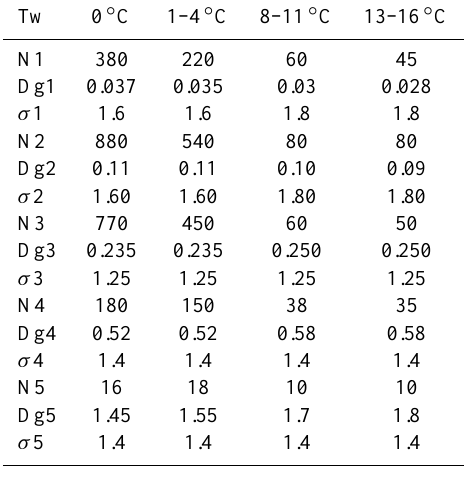
number density for the different salinity bins were compared (Fig. 6). Relative particle number concentrations for particles between 0.10 µm <D p < 0.23 µm are higher for the lower salinities and decrease with increasing salinity until they re- main stable at a salinity of about 15 g kg − 1 . As the